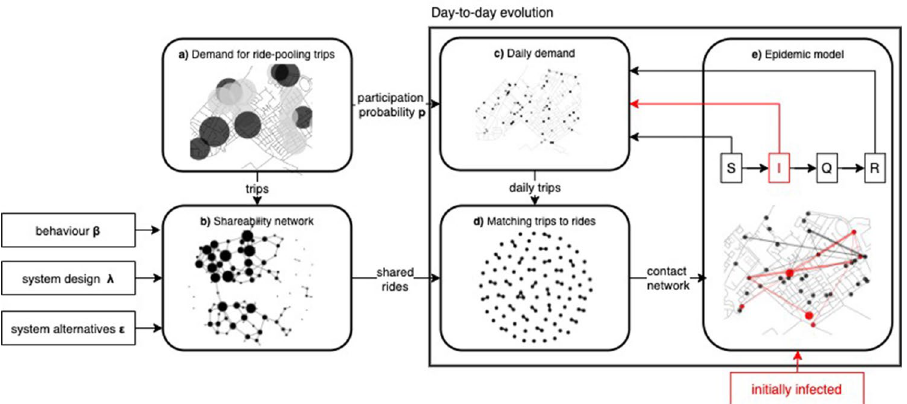
Figure 1. Methodology at glance: We consider travel demand for ride-pooling trips ( a ), for which we compute a shareability network ( b ) with a given behavioural parameters β , system design (cid:31) and alternatives’ attractiveness ǫ . We simulate the day-to-day evolution of spreading until the virus is halted. Each day we obtain the daily demand ( c ), consisting of those who want and can travel (decided to travel with probability p and are not quarantined). Daily trip demand is optimally assigned to shared rides, which forms the contact network ( d ) on which virus spreading is then modelled ( e ). Starting from initially infected travellers, each day we simulate epidemic transitions: susceptible travellers are infected by infected co-travellers who quarantine after 7 days and return immune to the system after 14